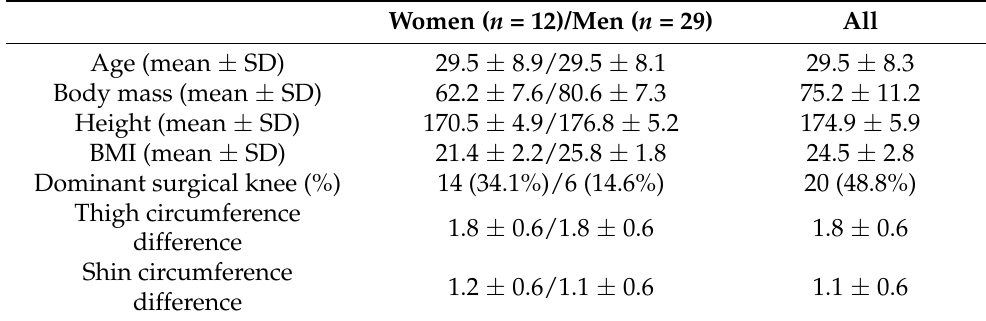
Table 2. Characteristics of the study